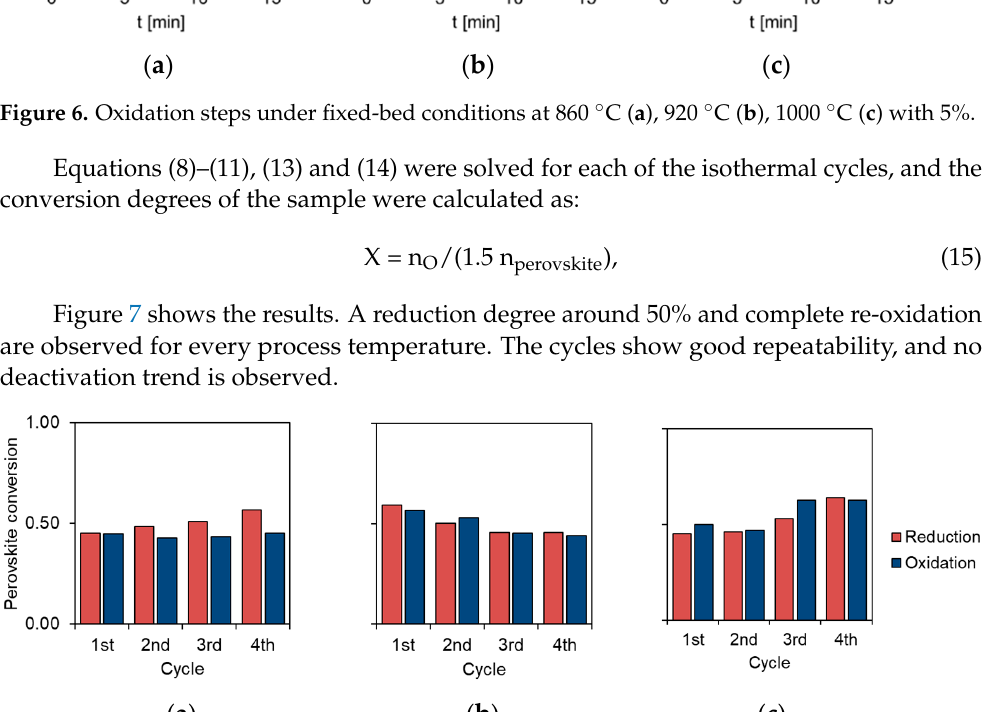
Figure 8. Conversion degree during reduction/oxidation isothermal cycles at 920 °C with H 2 O. 3.2. Fluidized-Bed Experiments Four isothermal cycles were conducted at 900 °C. During the first cycle the CH 4 feed was fed for 19 min to assess the time needed for the total reduction of the perovskite. For the following two cycles, the CH 4 feed was interrupted after 7 min to avoid CH 4 cracking and C deposition. Finally, the fourth cycle was carried on for 16 min to reach again full conversion of the perovskite. Figure 9 shows the reaction profiles of the second and fourth cycles. The reduction profiles (Figure 9a) show good repeatability. Total conversion of the perovskite is achieved in about 12 min and CH 4 decomposition initiates immediately after. The oxidation profiles (Figure 9b) differ for the Boudouard reaction, occurring in the fourth cycle.